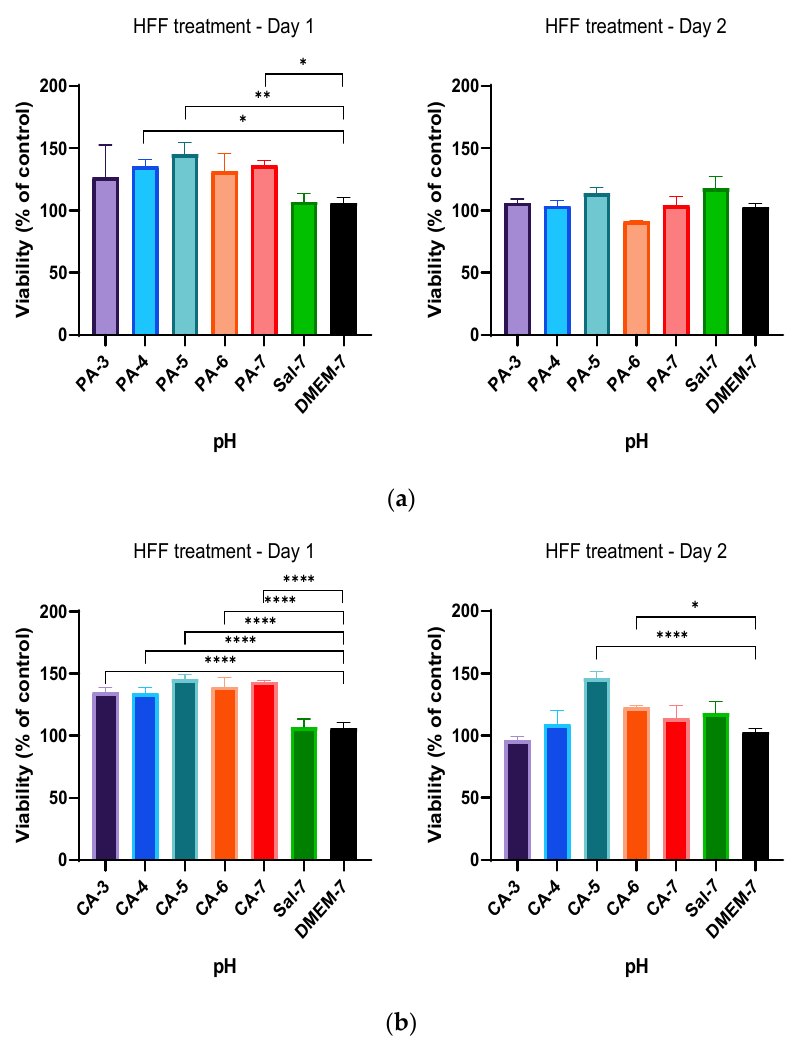
Figure 3. Percentage viability of HFF cells when treated with ( a ) 0.01 M phosphoric acid (PA) buffers with pH ranges from 3 to 7 and ( b ) 0.01 M citric acid (CA) buffers with pH values of 3, 4, 5, 6 and 7 utilizing the standardized MTT protocol of 24 h continuous treatment without a resting period. HFF cells metabolized well with phosphoric acid buffer treatments of pH 4, 5 and 7, while the metabolic rates of HFF cells were all statistically significant when treated with citric acid buffers at T = 24 h (Day 1). Each bar represents the mean ± standard deviation. * p < 0.05, ** p < 0.01 , ***p < 0.005 and ****p < 0.001 indicates that the results obtained were statistically significant from those of the control group (DMEM-7).